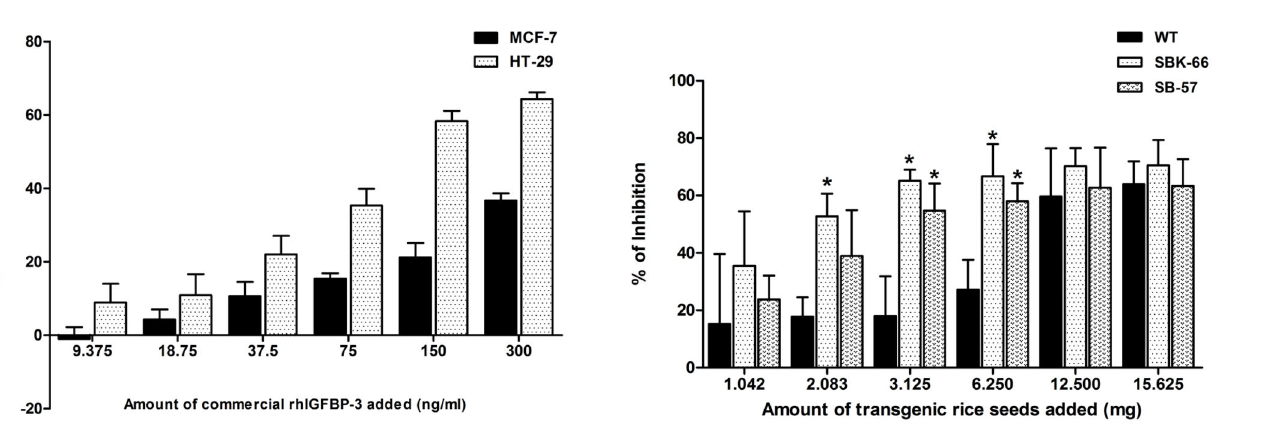
Figure 6. Inhibitory effect of different concentration of rice-produced rhIGFBP-3 on HT-29 human colon cancer cells. Different concentration of seed proteins (ranged from 1.042 to 15.625 mg) from WT and transgenic SBK-66 and SB-57 lines were used to treat HT-29 cells. Data are shown as means ± SD. * p < 0.05 and ** p < 0.01 denote statistically significant and very significant differences, respectively, between transgenic lines and WT.